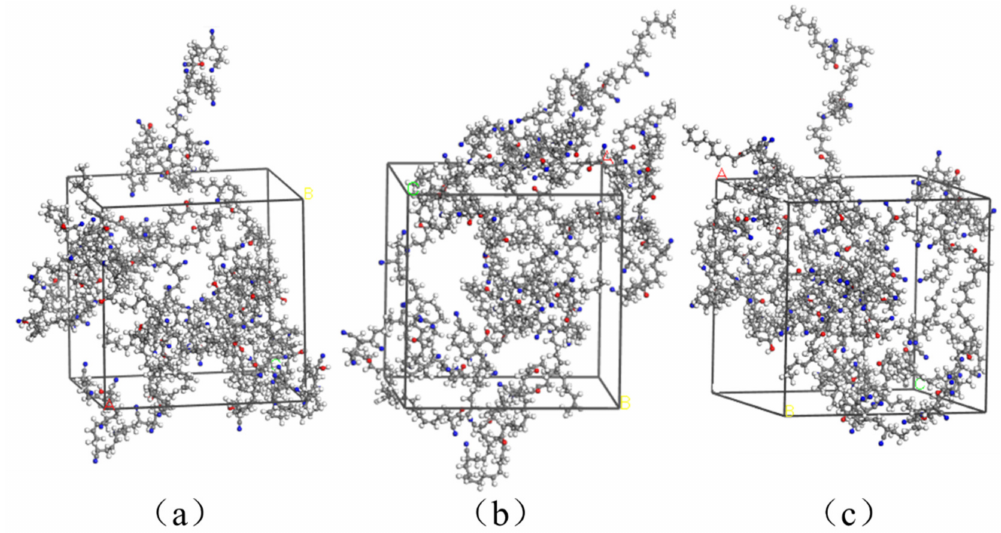
Figure 4. The aged nitrile rubber (NBR) model: ( a ) aged NBR model modified by hydroxyl groups (OH-NBR); ( b ) aged NBR model modified by carbonyl groups (CO-NBR); ( c ) aged NBR model modified by hydroxyl groups and carbonyl groups